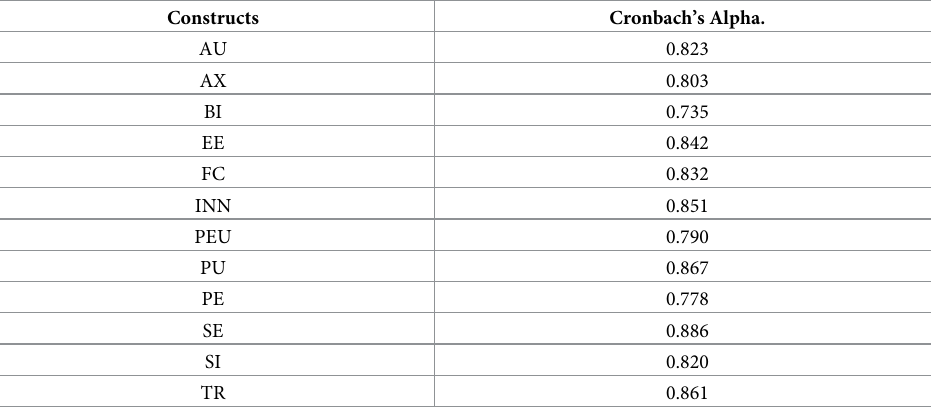
Table 2. Cronbach’s Alpha values for the pilot study (Cronbach’s Alpha �